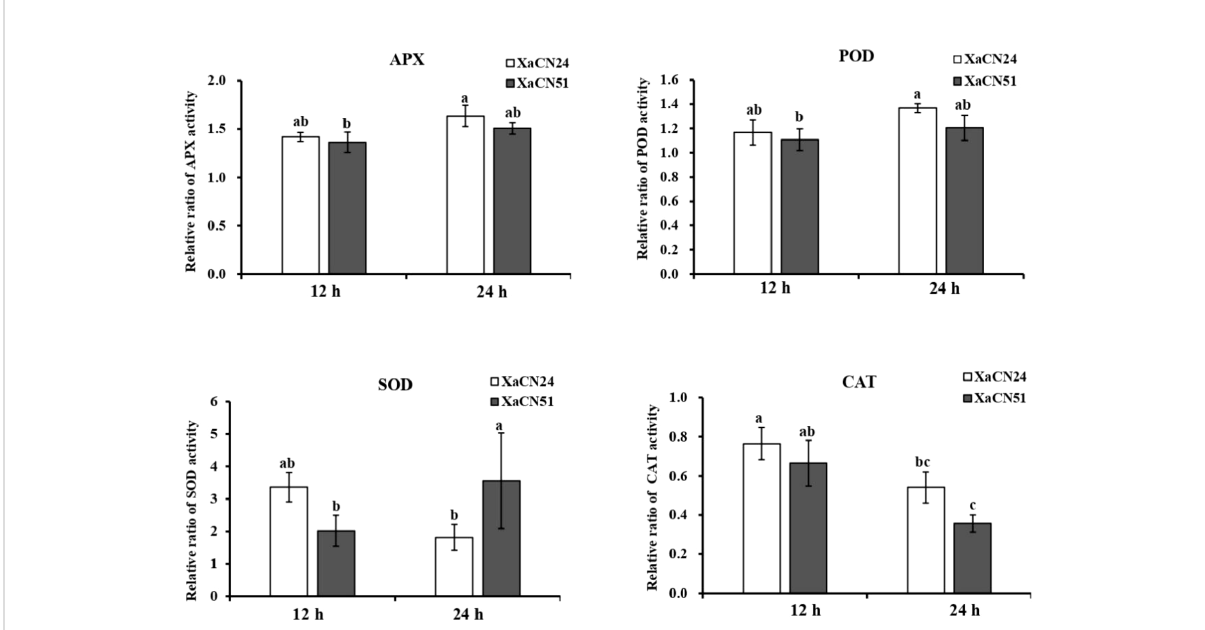
FIGURE 4 Changes of relative ratio of antioxidant enzyme activity in sugarcane leaves inoculated with two strains of Xanthomonas albilineans (XaCN24 and XaCN51). APX, ascorbate peroxidase; POD, peroxidase; SOD, peroxidase, and CAT, catalase. Each vertical bar represents the mean ± standard deviation of fi ve leaf subsamples collected 12 and 24 hours after inoculation and three technical replicates per subsample. Each leaf subsample is issued from a pooled sample of fragments collected from 35 inoculated leaves. Means with the same letter are not signi fi cantly different at P = 0.05 according to Duncan ’ s test.